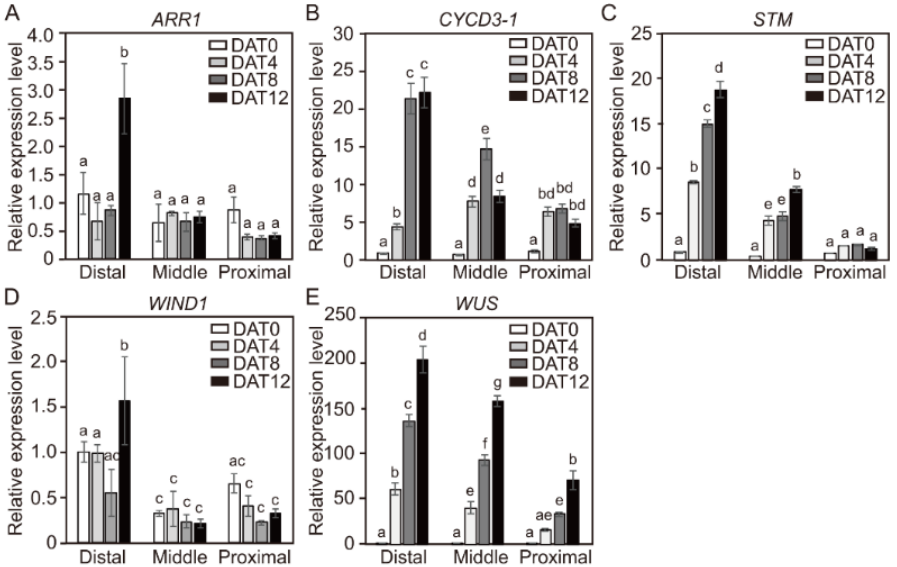
Figure 7. The relative expression levels of CYCD3-1 and shoot regeneration regulatory genes in hypocotyl explants in di ff erent positions for tomato seedlings during incubation in shoot induction medium (SIM). The relative gene expression levels of ARR1 ( A ), CYCD3-1 ( B ), STM ( C ), WIND1 ( D ), and WUS ( E ) in DAG4 hypocotyl seedling. Data are representative of the results from three independent experiments. Di ff erent letters on the bars indicate significant di ff erences between each treatment (ANOVA followed by a Tukey’s test, p < 0.05). DAG = day after germination; DAT = day after